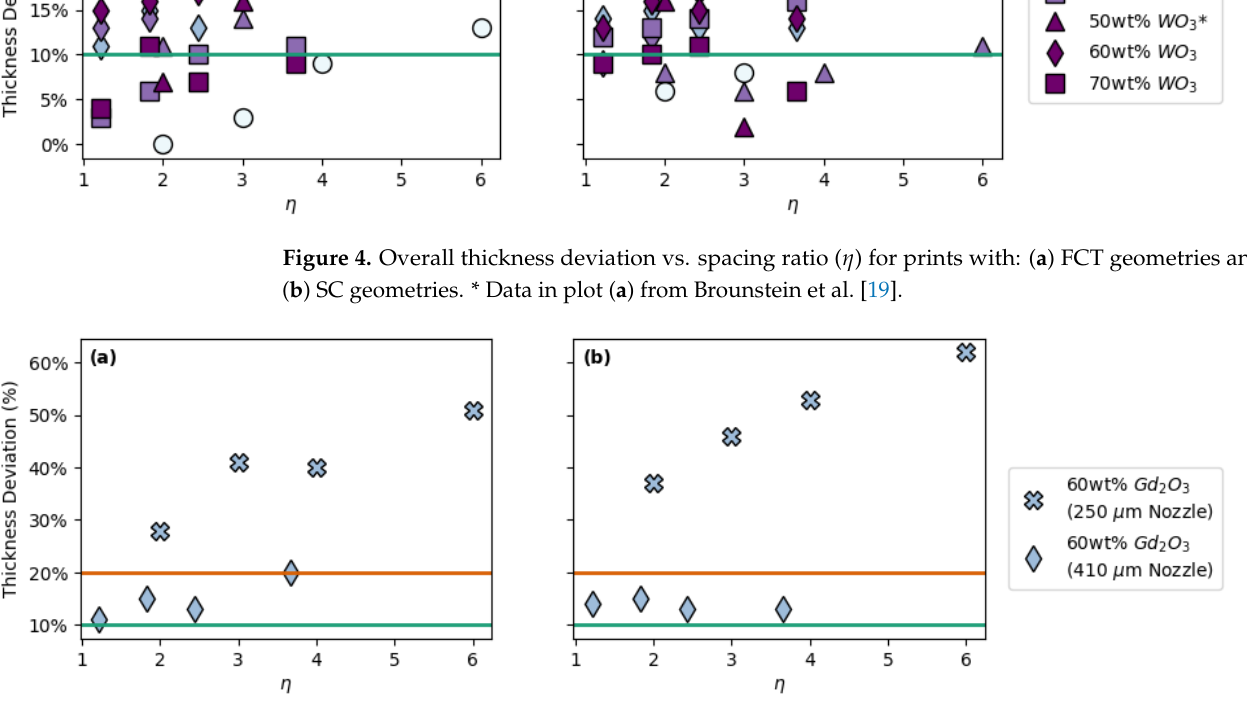
Figure 4. Overall thickness deviation vs. spacing ratio ( η ) for prints with: ( a ) FCT geometries and ( b ) SC geometries. * Data in plot ( a ) from Brounstein et al. [19].